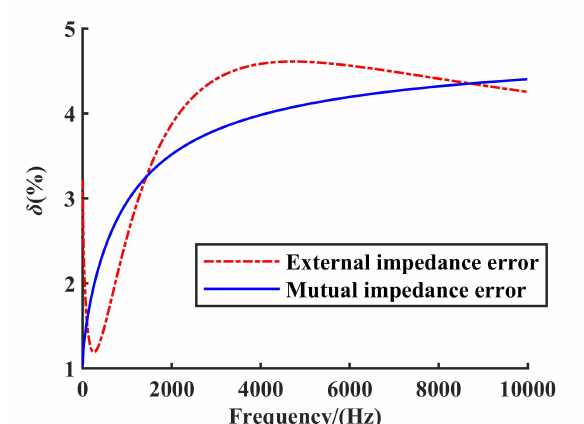
Fig. 9. Error of double-layer external impedance and mutual